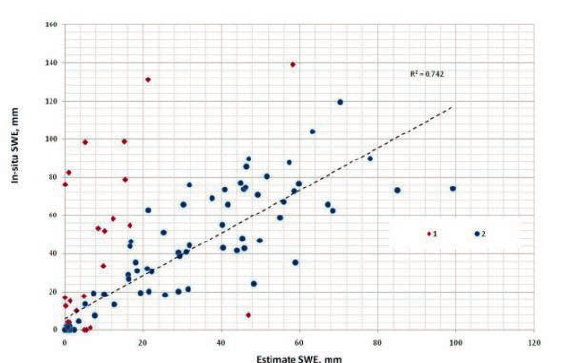
Fig. 3 Linear relationship between in situ and estimated SWE data for the Oka river basin (1) before and (2) after overshoots in SWE values are discarded. With SWE overshoots, caused by the presence of liquid water in the snowpack during thaws, excluded from the data series, there is a clear linear relationship between the in situ and estimated SWE data (Fig.